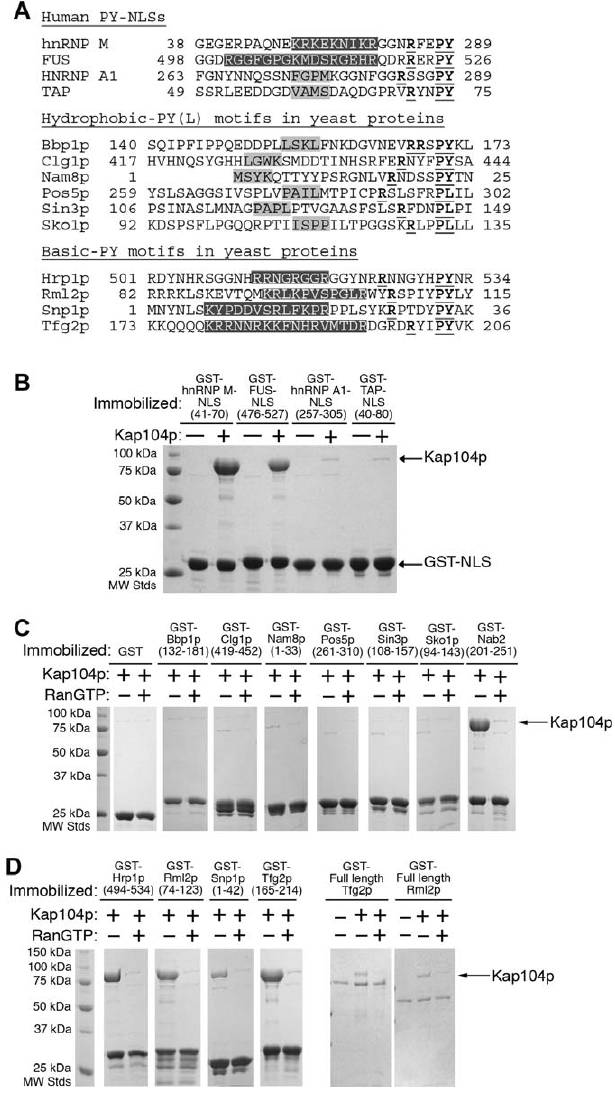
Figure 2. Kap104 Recognizes Basic PY-NLSs but Not Hydrophobic PY- NLSs (A) Sequences of known PY-NLSs in human proteins and predicted hydrophobic-PY(L) (shaded in light gray) and basic PY motifs (shaded in dark gray) in yeast proteins. The RX 2–5 PY(L) motif is underlined. (B) Binding assays of Kap104p and immobilized human bPY-NLSs (hnRNP M and FUS) or human hPY-NLSs (hnRNP A1 and TAP). (C) Binding assays of Kap104p with six immobilized predicted yeast hPY(L)-NLSs. GST and GST–Nab2p are included as controls. Faint bands at ; 70 kDa are likely heat shock protein contaminants. (D) Binding assays of Kap104p and immobilized predicted bPY-NLSs or full-length proteins. GST–Hrp1p is included as a control. Bound proteins are stained with Coomassie blue.